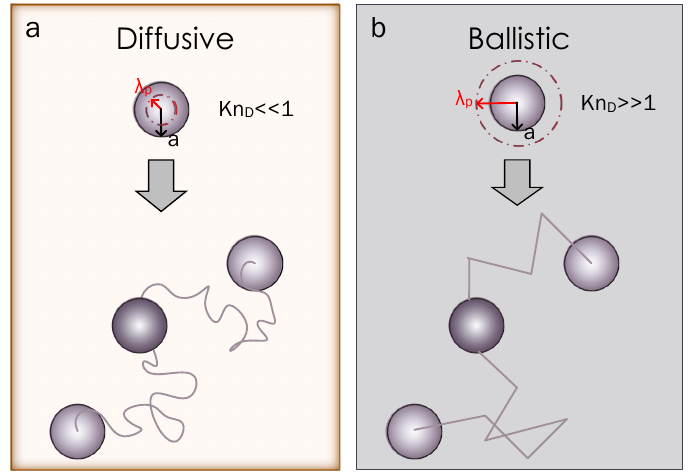
Figure 1. The particle-persistent distance λ p and the particle’s radius a are shown. The corresponding diffusive Knudsen numbers Kn D = λ p / a are indicated along with the trajectories of colliding monodisperse particles in the ( a ) diffusive and ( b ) ballistic coagulation